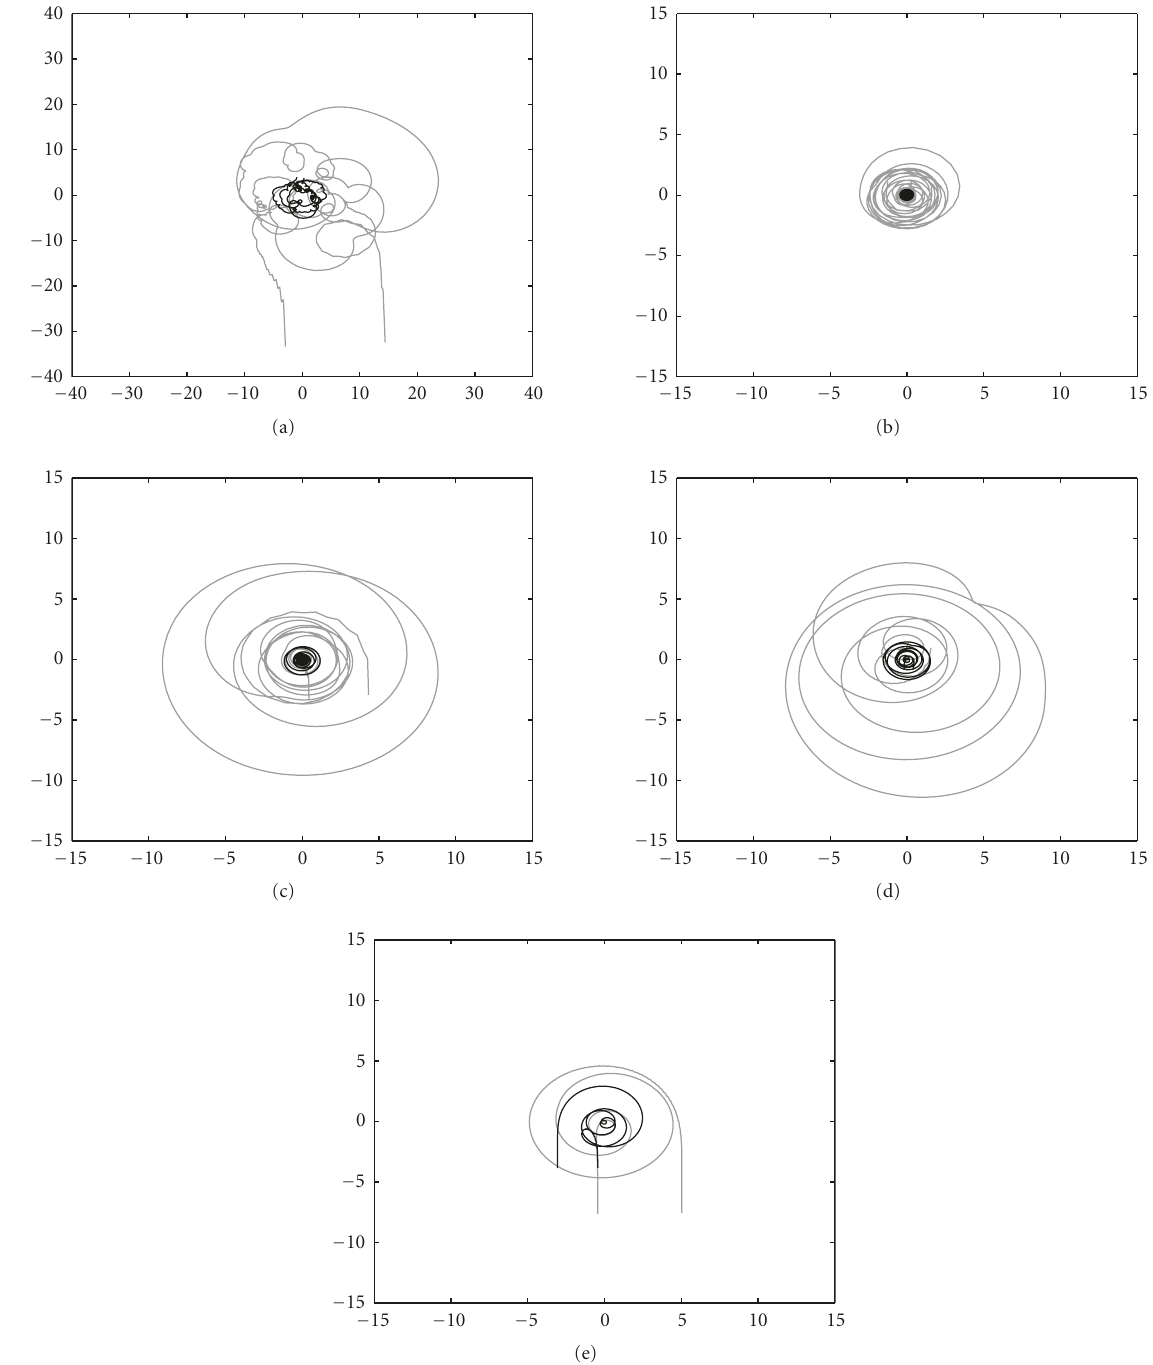
Figure 3: Representation in the complex plane of the analytic signal of a healthy control subject (black lines) and healthy elderly subject (grey lines) for the AP direction (a). Analytic signals of the first four IMFs (b): IMF1, (c): IMF2, (d): IMF3, and (e): IMF4.